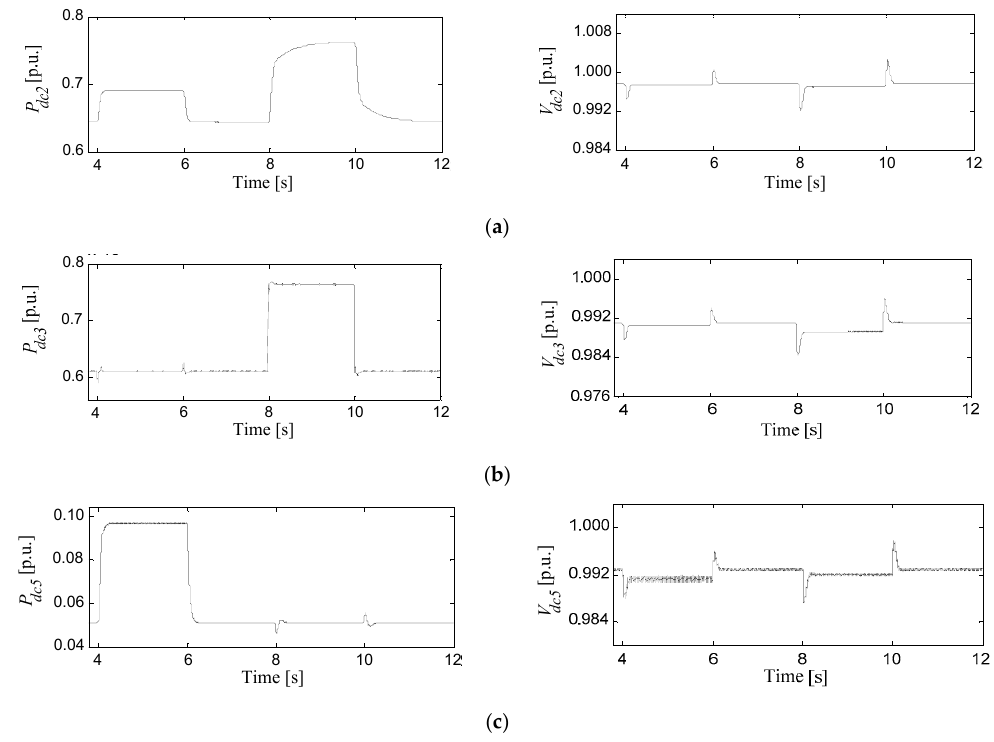
Figure 9. The influence of the proposed dynamic droop loop with the same load-side disturbances according to Table 6— K d 1 = 20, K d 2 = 10, ω d 1 = ω d 2 = 300 r / s ; ( a ) VSC 2; ( b ) VSC 3; ( c ) DC/DC converter 5.